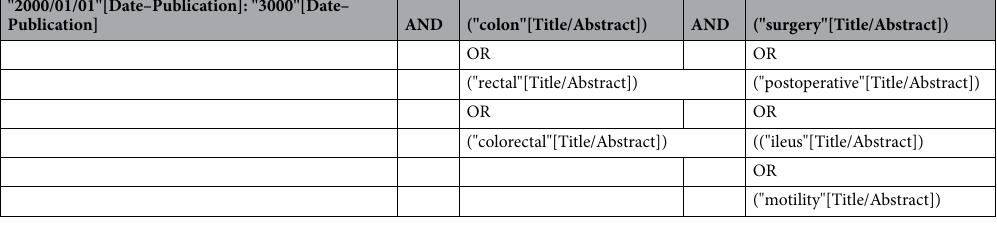
Table 1. Search strategy in the